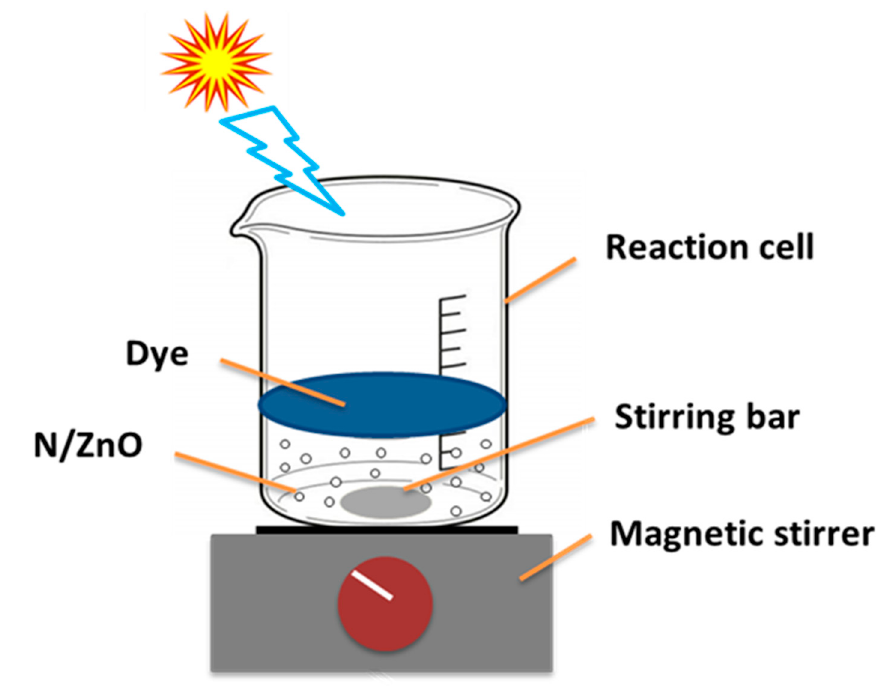
Figure 1. Schematic diagram of the reactor for photocatalytic degradation of dye.